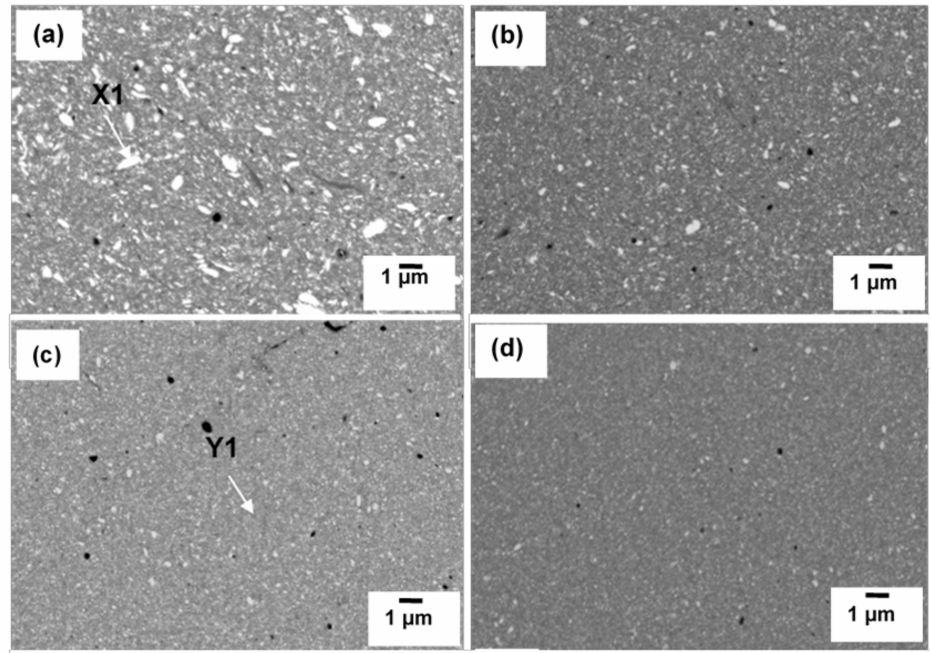
Figure 5. SEM images of Cu-W-C powder milled for ( a ) 10 h, ( b ) 20 h, ( c ) 40 h and ( d ) 60